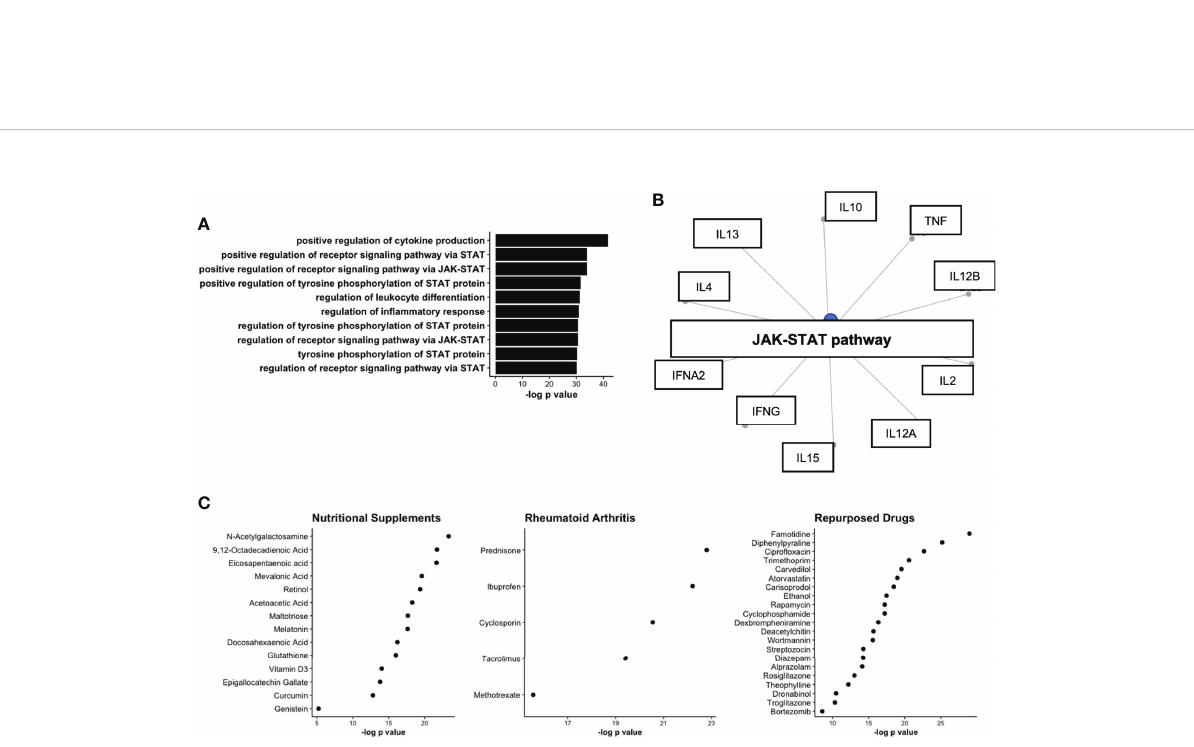
FIGURE 5 Network analysis of protein co-expression module upregulated in ACPA positive FDR. (A) Upregulated GO pathways based on proteins identi fi ed in co-expression network. (B) Gene concept plot displaying common node (JAK-STAT), connecting protein module members. (C) Drug network analysis split by broad classes of pharmaceutical including nutritional supplements, Rheumatoid Arthritis treatments, and drugs approved for other diseases/conditions (Repurposed). STAT, signal transducer and activator of transcription; JAK, Janus Kinase; ACPA, anti-citrullinated protein antibodies.